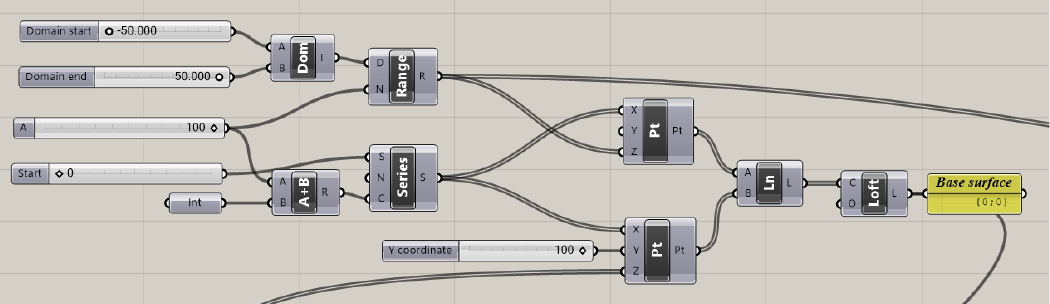
Figure A1. Block script for roof’s base surface creation.